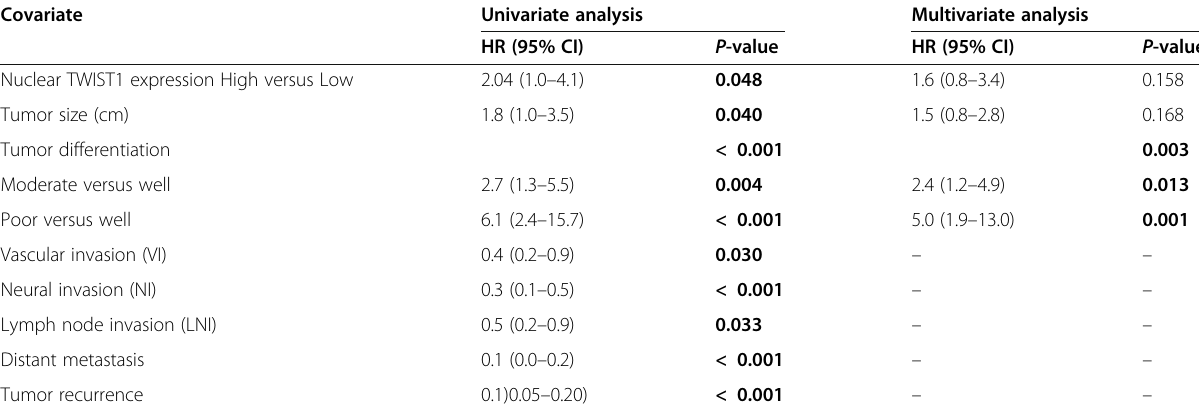
Table 5 Univariate and multivariate Cox regression analyses of potential prognostic factor for disease-specific survival (DSS) in patients with colorectal cancer